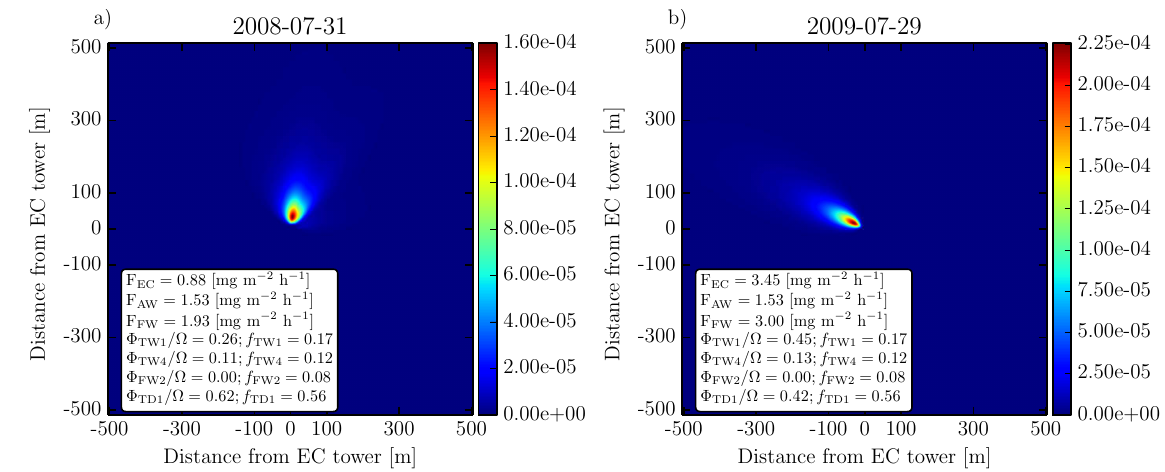
Figure 6. Examples of the modelled footprints for 31 July 2008 (a) and 29 July 2009 (b) . The images show 2-D distributions of the footprint functions. The inset text boxes show values of the measured EC flux ( F EC ), calculated fluxes ( F AW and F FW ), integrated footprint function per vegetation type normalized by (cid:127) ( 8 i ) and fractional areas of vegetation types ( f i ).